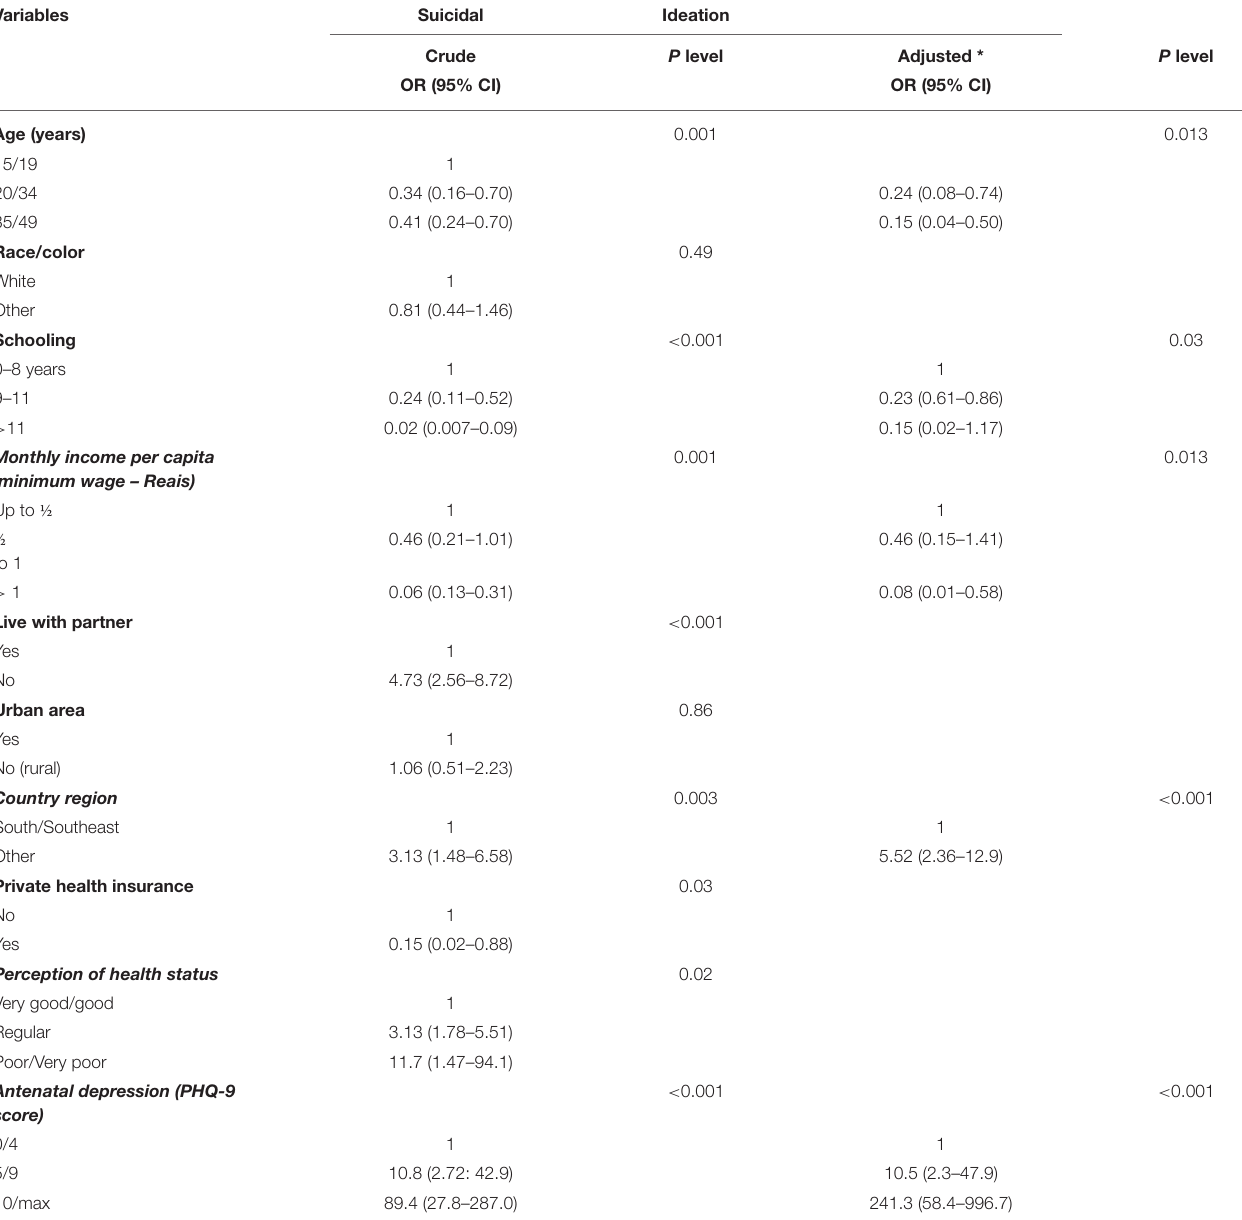
TABLE 2 | Associations between suicidal ideation, sociodemographic factors, and obstetric risk factors in the Brazilian National Survey of Health, 2019.